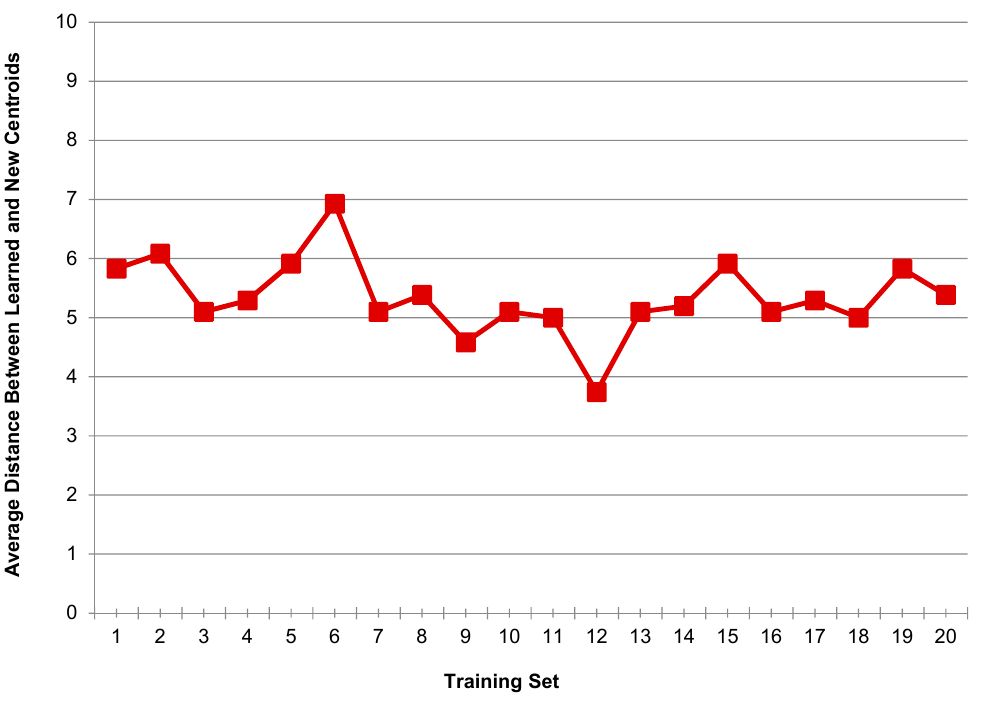
Figure 3. Average distance between the learned centroids and the new centroids for different training sets.